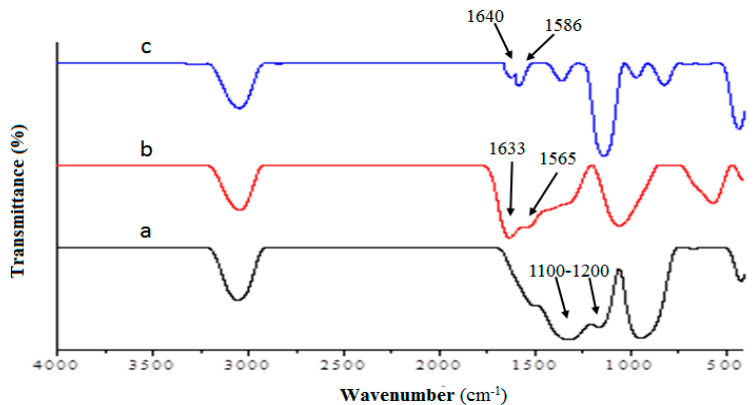
Figure 2. FTIR spectra of Gr-Au ( a ), Gr-Au-Chit ( b ), Gr-Au-Chit/Tyr ( c ).